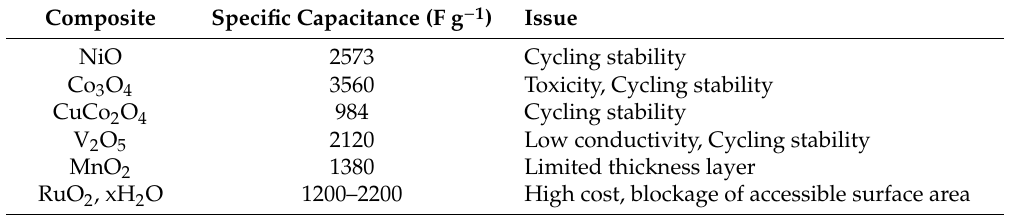
Table 3. The theoretical capacitance of various composite with issues.